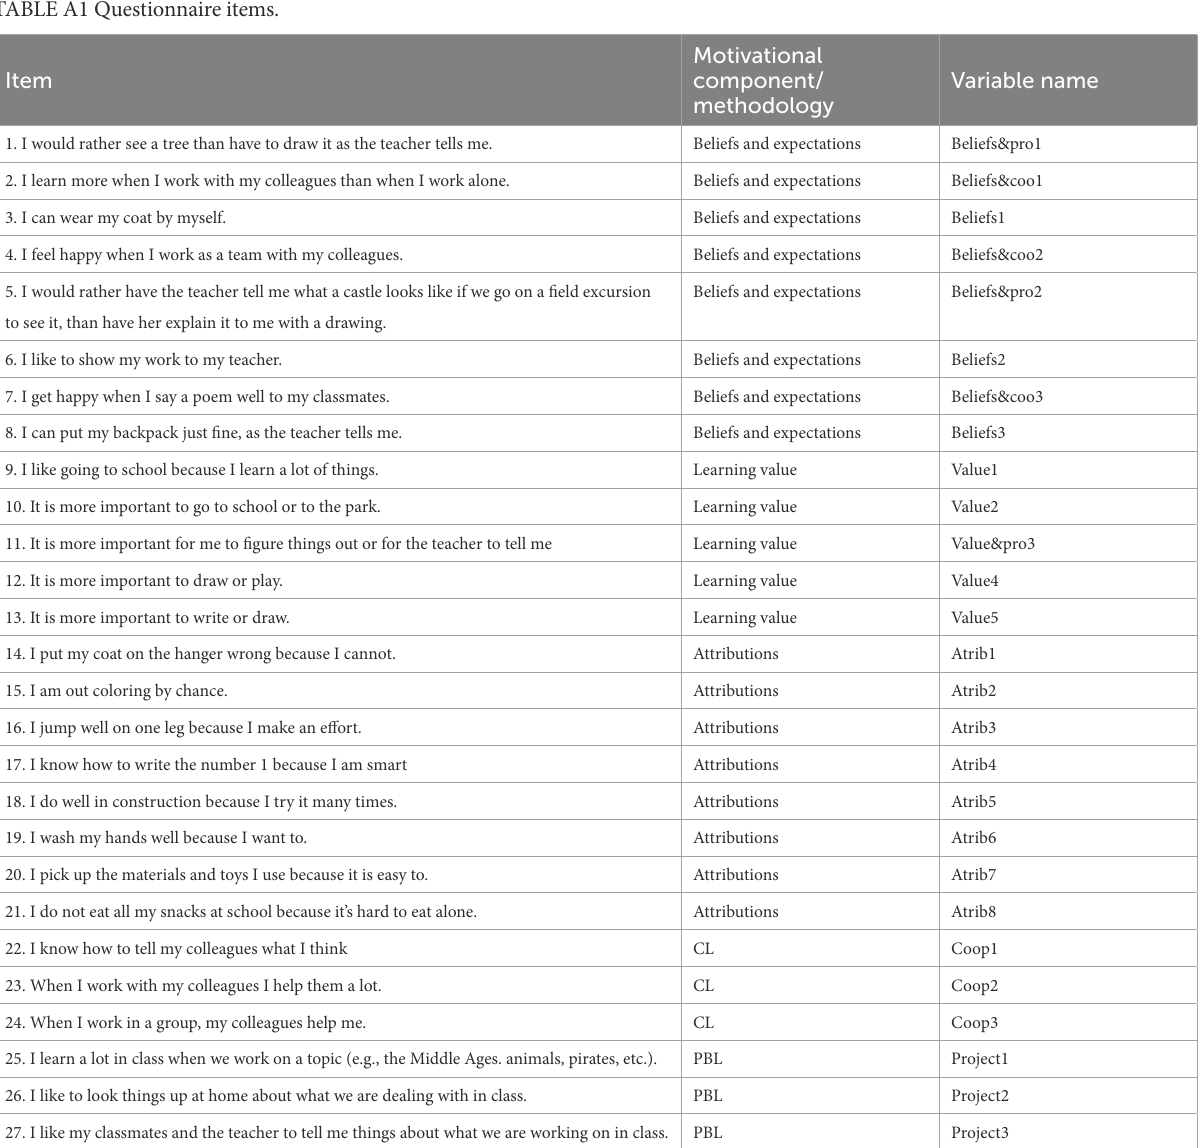
TABLE A1 Questionnaire